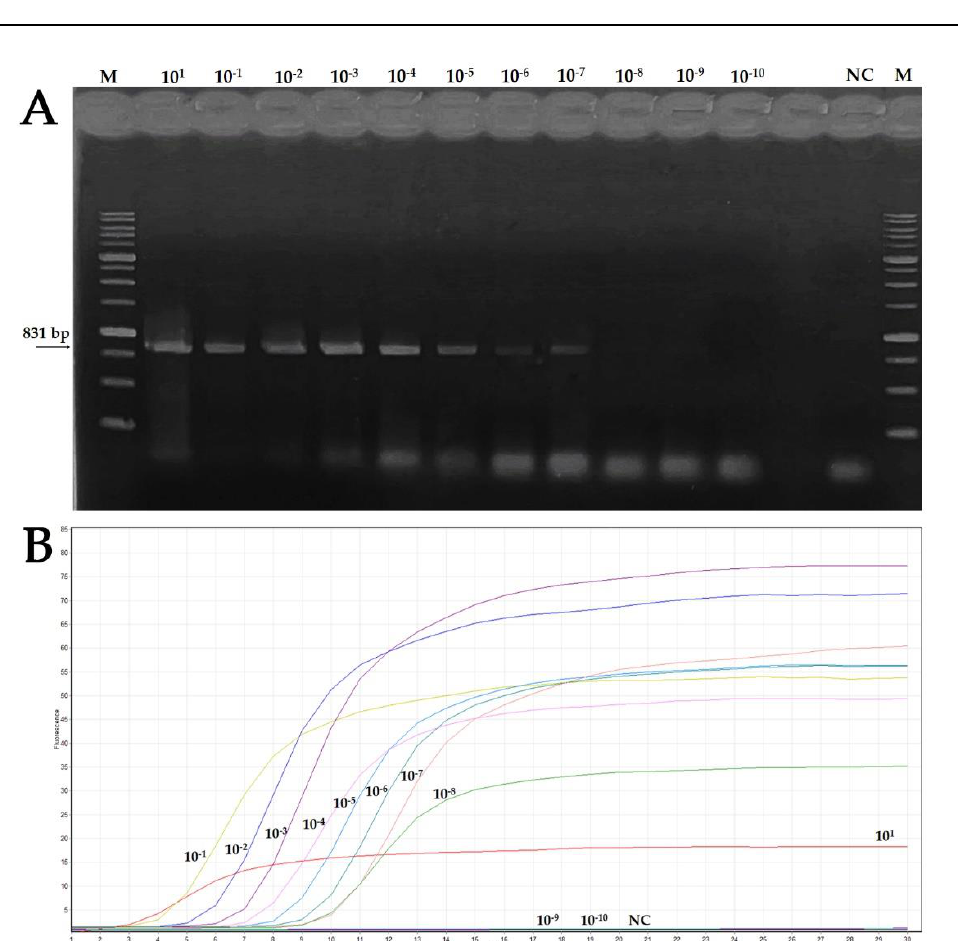
Figure 3. Sensitivity of the end point PCR (panel A ) and real-time LAMP (panel B ) for OEGV detection. The assay was conducted using 10-fold serial dilutions of pcr-DNA. Panel ( A ): Agarose gel electrophoresis of PCR products; M: 1 Kb ladder marker, NC: negative control. Panel ( B ). Fluorescence of the 10-fold serial dilutions analyzed. Fluorescence increased in positive sample curves (from 10 − 1